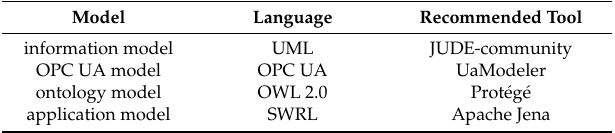
Table 2. Recommended language and related software tools for